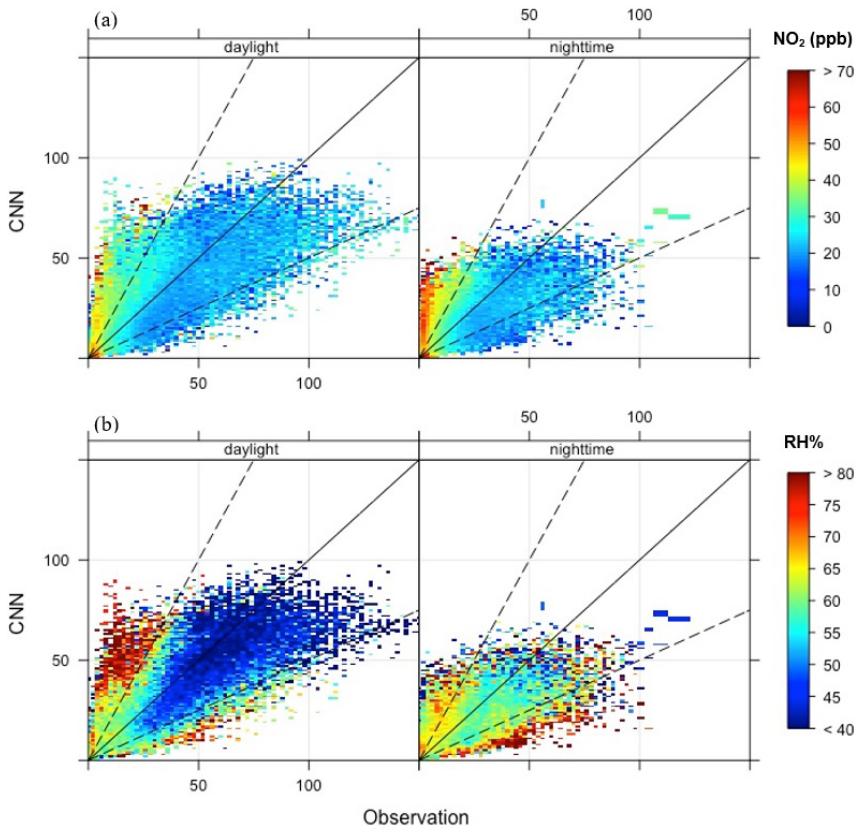
Figure 5. Scatterplots comparing CNN predictions and observations with respect to levels of (a) NO 2 concentrations and (b)